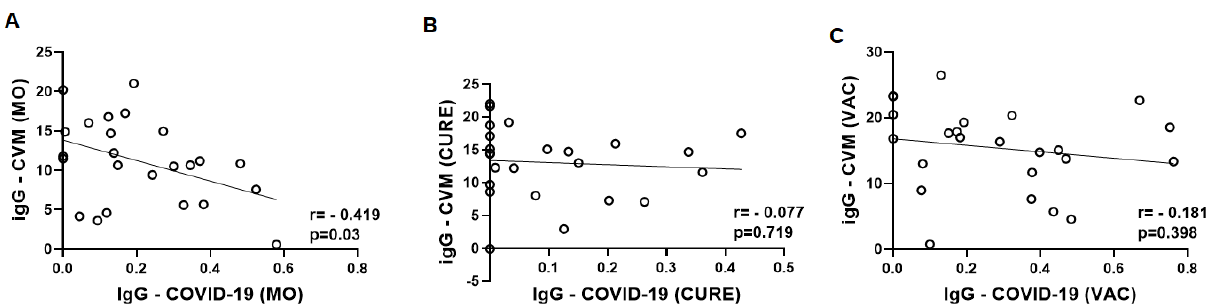
Figure 3. Spearman coefficient correlation analysis between total serum levels of CMV-specific IgG (IU/mL) and COVID-19-specific IgG (O.D. 450 nm) in the older adults who participated in the study on three different occasions: during the micro-outbreak of SARS-CoV-2 infection (MO, A ), 6 – 8 months after this infection (CURE, B ), and 30 days after administration of the second dose of Cha- dOx-1 vaccine (VAC, C ).